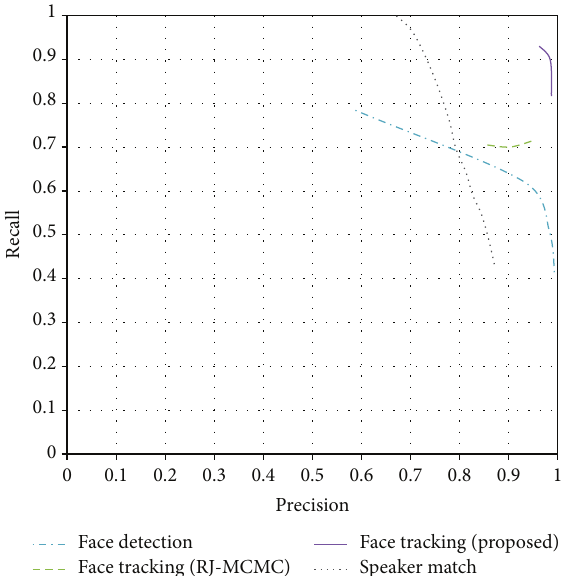
Figure 13: Recall versus precision for face detection, face tracking, and speaker match (Dataset 2). Speaker match shows lower perfor- mance in case of Dataset 2 due to the presence of 4 participants within a sector of 100 ∘